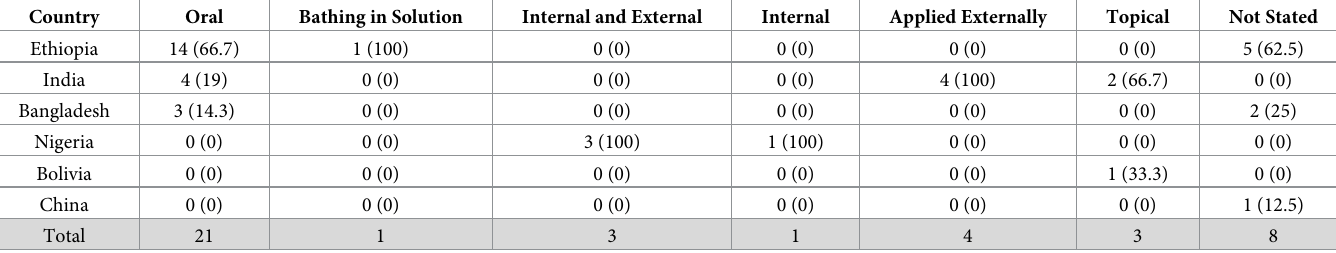
plants, 9.8%), Bolivia (1 plant, 2.4%), China (1 plant, 2.4%). Plant use varied based on the plant part, the route of administration, and mixtures with other plants. Leaves (10 plants, 24.4%) and roots (9 plants, 22.0%) were the most common plant parts used in remedies (Table 1). The oral route was the most common listed means of administering the remedy (21 of 41 plants, or 51.2%); however, the route of administration was not stated for 19.5% of these plants (Table 2). The plants were mostly oral remedies in the form of tea or juice, and some were mixed with milk, honey, beer, or other liquids. Most of these plants were mixed with at least one other plant species; 26 (63.4%) were used in mixtures whereas only 15 (36.6%) were the sole plant species in the remedy. Some articles described plant remedies being applied inter- nally, externally, or topically; these terms were not further defined in these articles. Duration of plant remedy use varied by plant species, and duration was often not described in the study. Additionally, there were no explained rationales for instituting a particular dura- tion of the remedy. Likewise, dosages for the plant remedies were often not stated, but dosages may have varied according to age of the patient and other factors [6,33,34]. Overall, no plant species or route of administration was consistently used for rabies treatment across countries. Of the 41 plants listed, there were seven families with two or more plant species. Solanaceae had three genera and six species represented ( Solanum indicum L., Solanum marginatum L., Euphorbiaceae had three genera and four species represented ( Croton macrostachyus Del., Compositae also had three genera represented ( Vernonia amygdalina Del., Spilanthes panicu- lata Wall., and Guizotia abyssinica (L.F.) Cass.). Three families had two genera represented Table 2. Route of plants used for rabies by country (N, %). Country Bathing in Solution Internal and External Applied